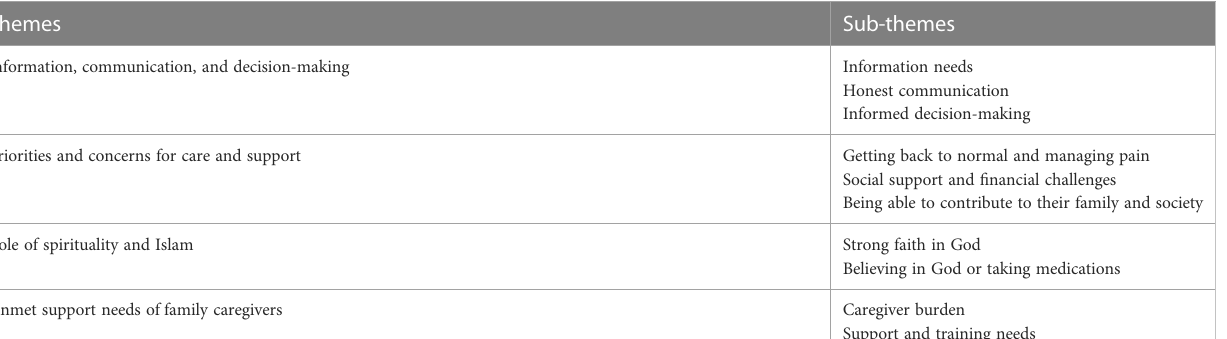
TABLE 2 Themes and